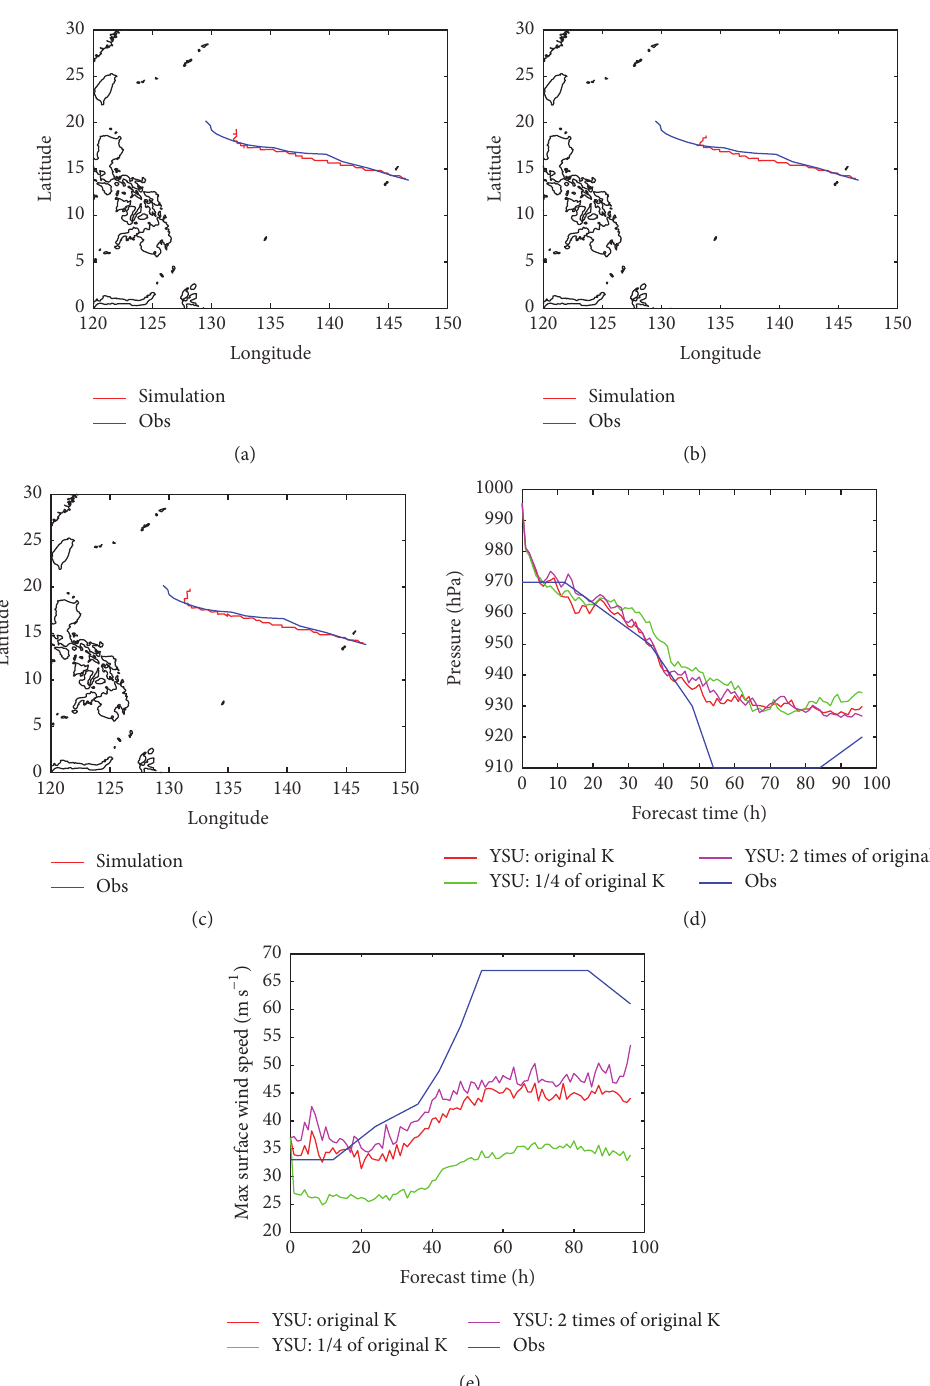
Figure 6: Case 5-Vongfong: (a) track simulated by the original YSU; (b) track simulated by the K025; (c) track simulated by the K200; (d) comparisons of center sea-level pressure; and (e) comparisons of maximum surface wind speed.